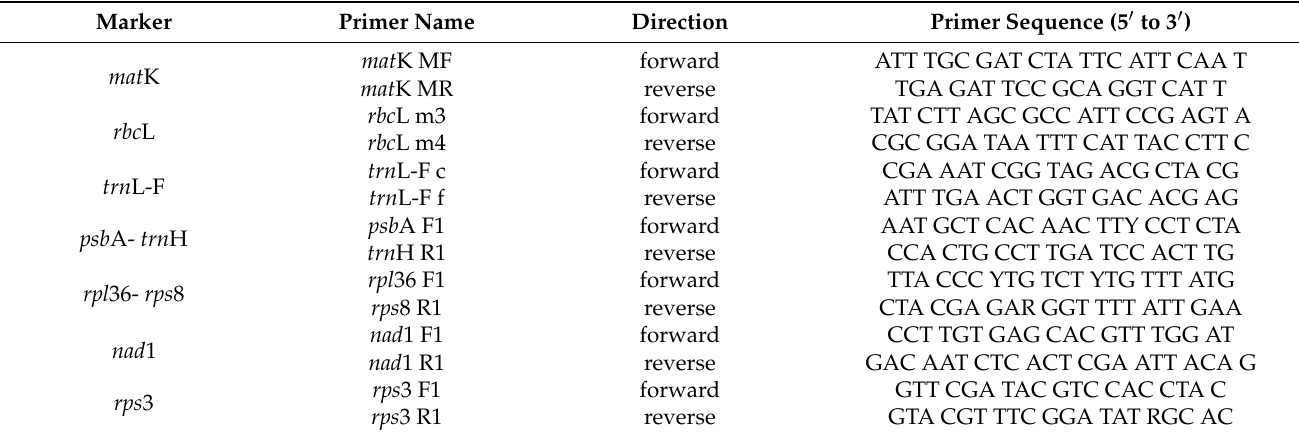
Table 2. Markers and primers used in this